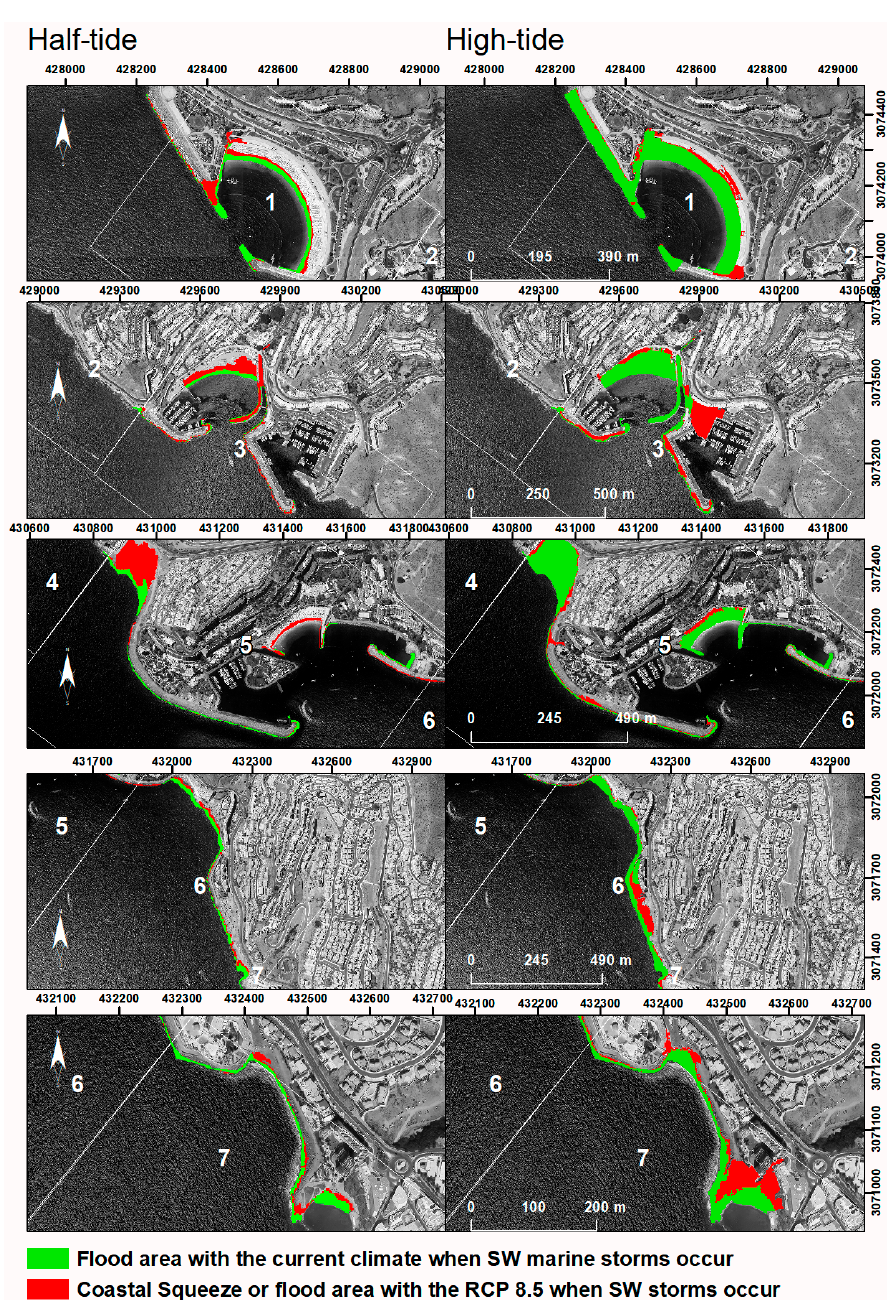
Figure 9. Coastal squeeze area. ( Left ): Coastal narrowing area (green) adding the flooded surface in an RCP 8.5 scenario (red) under half-tide conditions and when SW sea storms occur. ( Right ): Coastal narrowing area (green) adding the flooded surface in an RCP 8.5 scenario (red) under high-tide conditions and when SW sea storms occur.